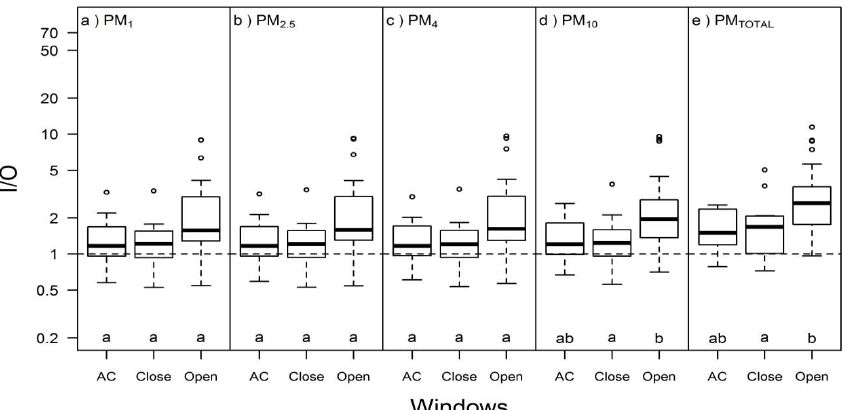
Figure 6. Boxplots of I/O in Building E (both campaigns) for ( a ) PM 1 ; ( b ) PM 2.5 ; ( c ) PM 4 ; ( d ) PM 10 ; and ( e ) PM TOTAL based on window opening. Categories are AC on (AC, windows presumably closed, n = 10), windows closed (Close, n = 16), and windows open (Open, n = 25). Different letters within the same box represent statistically significant ( p < 0.05) groups under the Kruskal ‐ Wallis multiple comparisons test. Dashed lines for equal indoor and outdoor concentrations (I/O = 1) are included for reference.